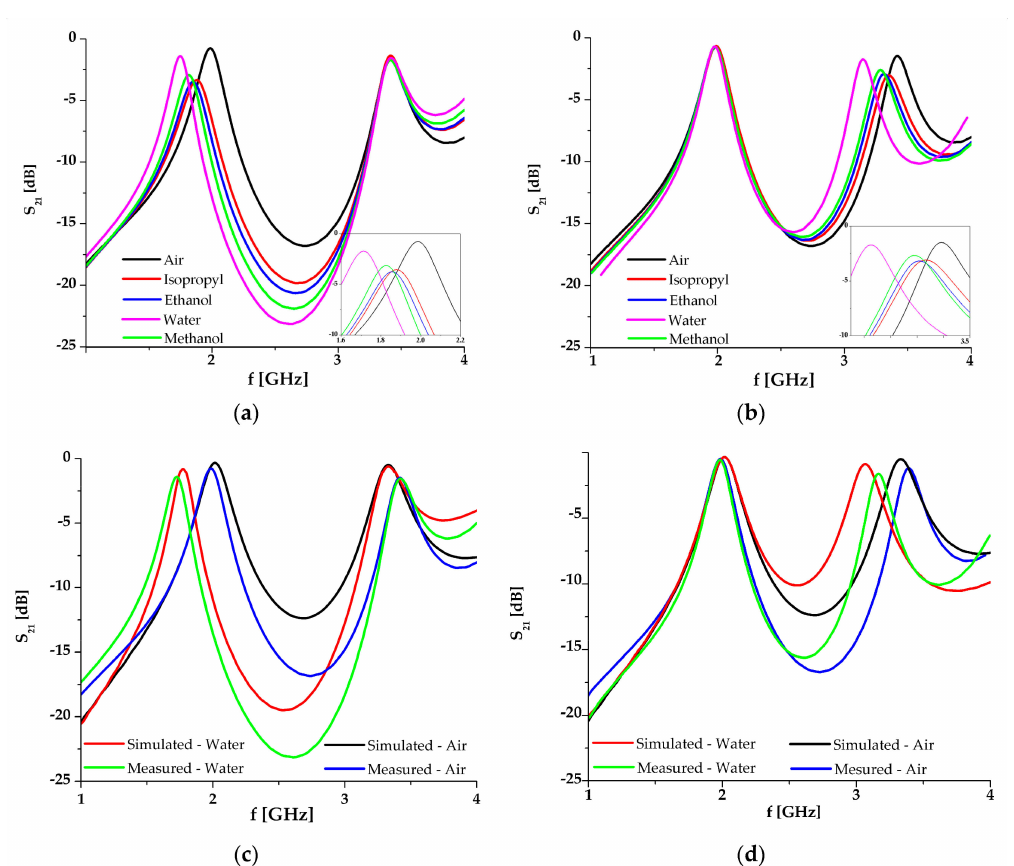
Figure 21. The results for the sensor with the first channel filled with tested liquids and the second one filled with air ( a ); the sensor with the first channel filled with air and the second one with the tested liquids ( b ); the comparison between the simulated and obtained results for the first channel filled by water/air ( c ) and with the second one filled with water/air ( d )